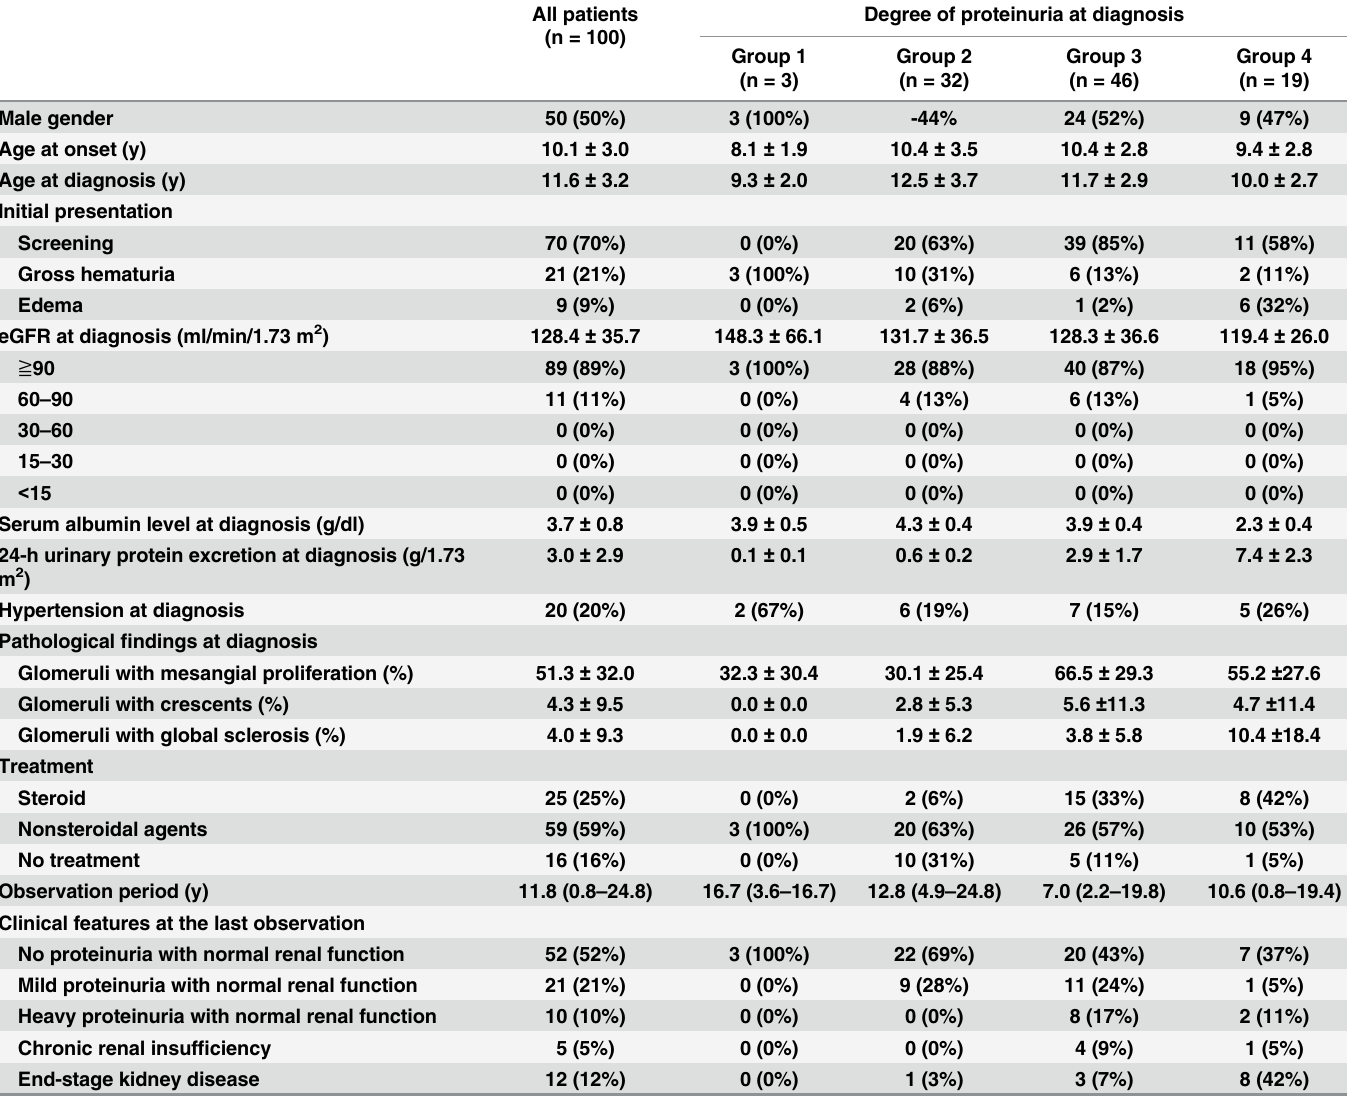
Table 1. Characteristics of